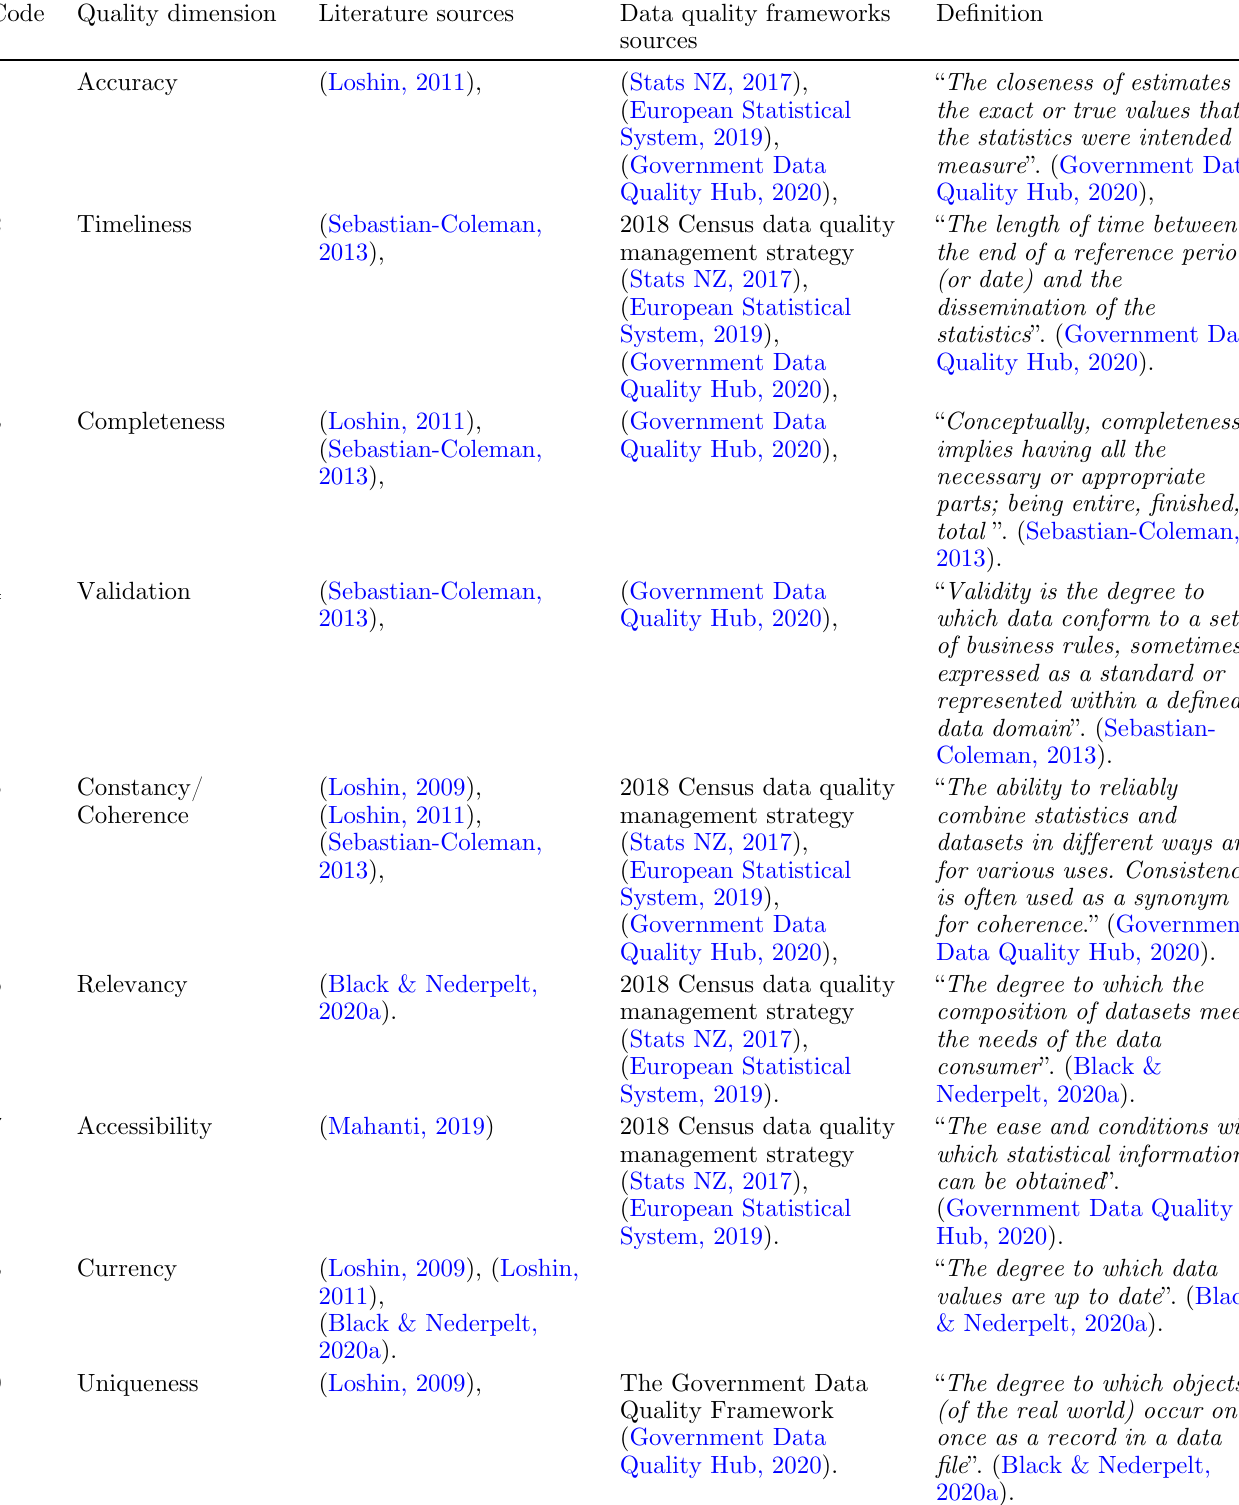
Table 2. Content and cross-tabulation analysis for the most frequent data quality dimensions and their related DQFs, collated from literature and NSOs. (Created by the